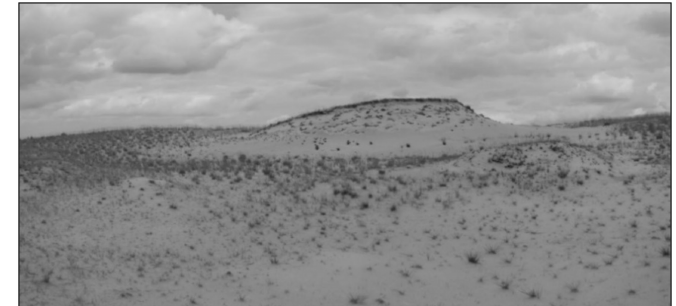
Figure 6. White dunes with grey (grassland) dunes in the background (photo by Arvydas Urbis).